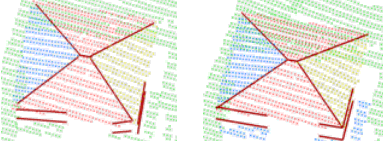
Figure 5: Geometric fitting of roof corner, associated with ridge-lines and step-edges: before (left), and after fitting (right)